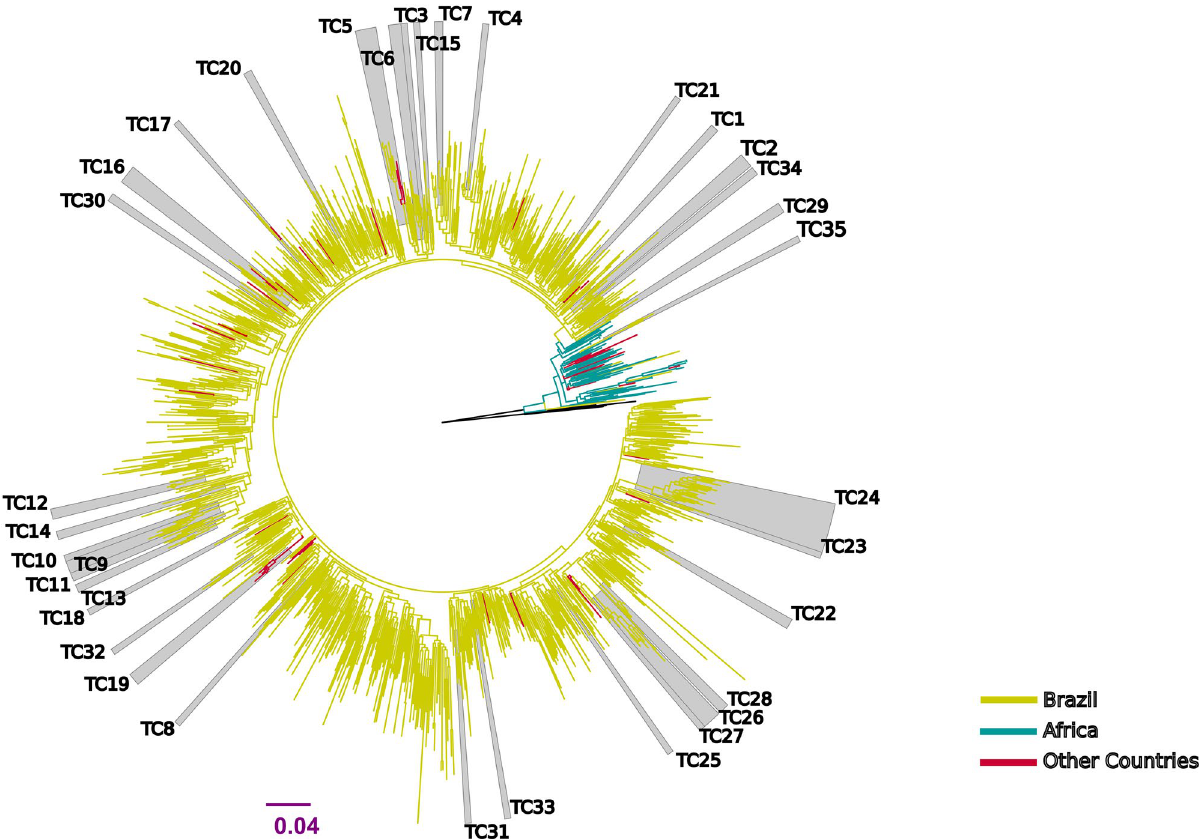
Figure 3. Maximum likelihood tree of the HIV-1 subtype C pol sequences (~ 1000 nucleotides) isolated in Brazil from treatment naïve individuals from 2008 to 2017 (n = 340) and closely related sequences from databases (total n = 1194). Multiple sequence alignments were performed using MAFFT v7.309 removing columns containing at least 10% gaps. Branch colors indicate the geographical origin of the sequences. Most subtype C sequences isolated from patients in Brazil are monophyletic (SH-like branch support 0.94) suggesting one single major founder event. Gray boxes indicate the positions of strongly supported clades (SH-aLRT ≥ 0.95). The branch lengths are drawn to scale with the bar at the bottom indicating nucleotide substitutions per site. Tree was rooted using HIV-1 subtype A1 reference sequences (black